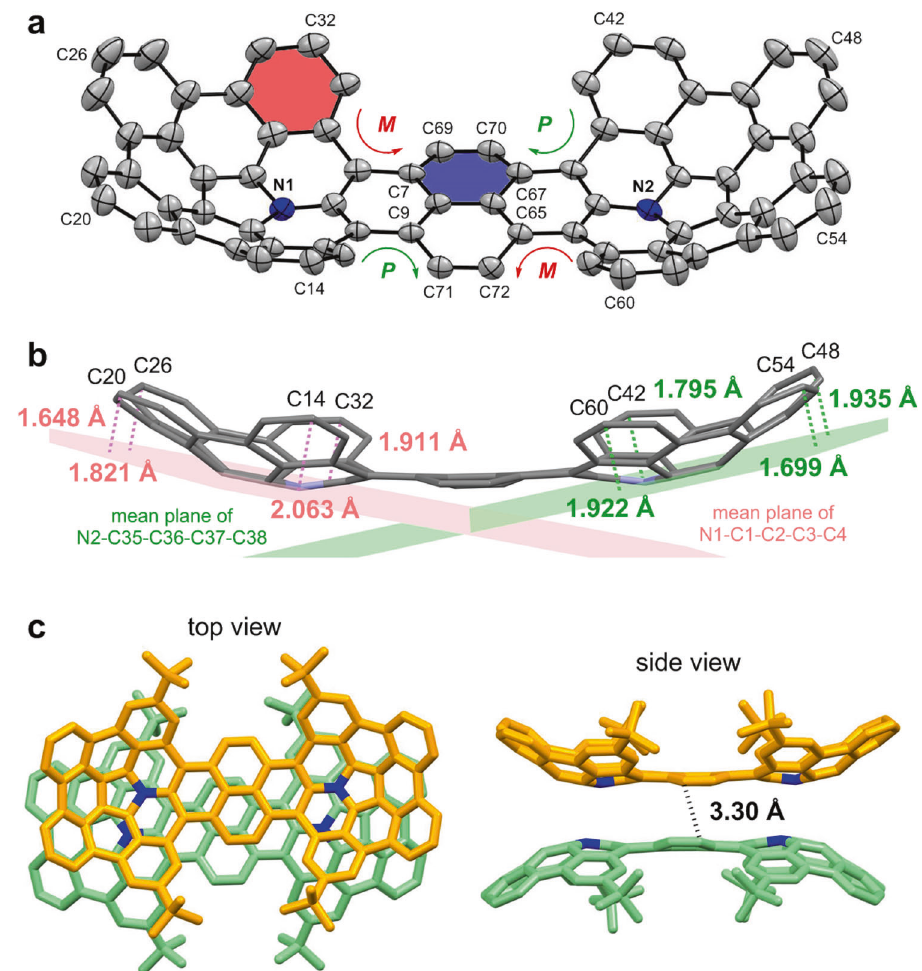
Fig. 3 X-ray crystallographic analyses of azacorannulene dimer 4a. a ORTEP structure of 4a with thermal ellipsoids at 50% probability. Hydrogen atoms and t -butyl group are omitted. b Bowl depths of 4a . Hydrogen atoms and t -butyl group are omitted. c Packing structure of 4a in a unit cell. Hydrogen atoms are omitted.